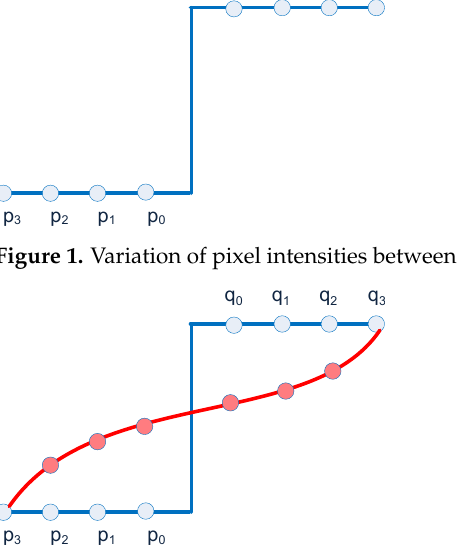
Figure 2. Smoothing of pixel intensities between block